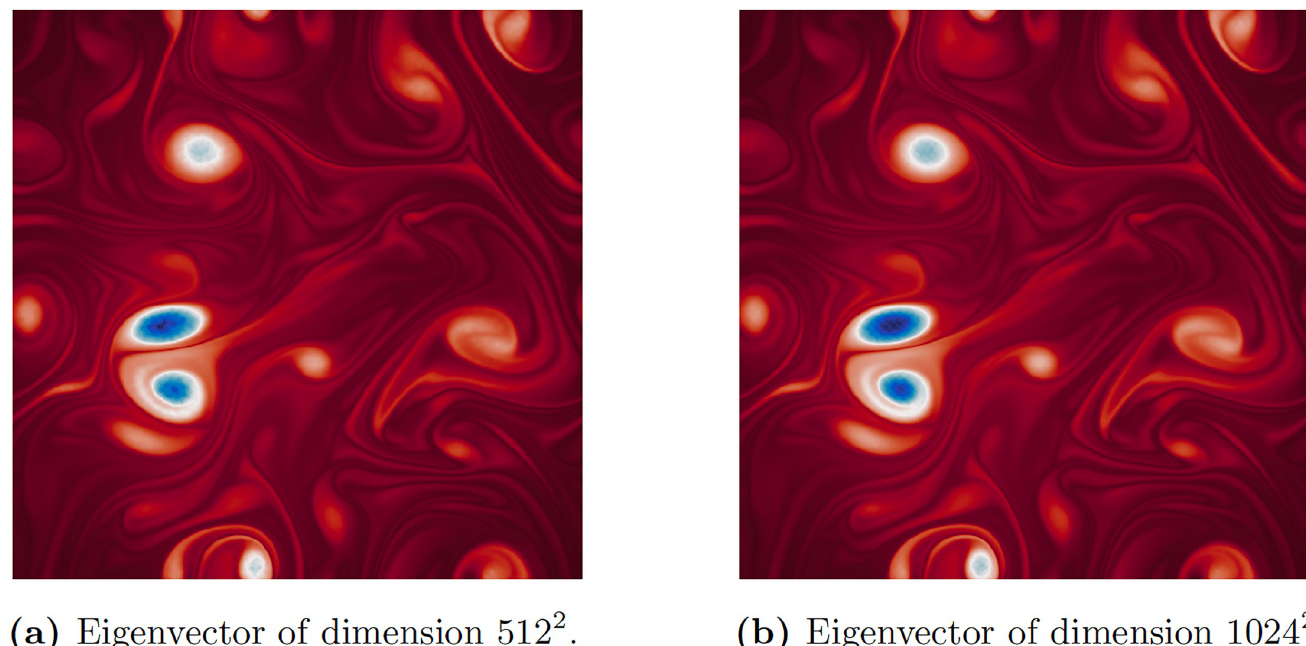
Fig 8. Approximated leading eigenvectors of the adjacency matrices for higher-resolution isotropic flow fields. Here, we are using the Nystro¨m method with Halton sampling. By visual inspection we can see that sampling only about 10% of the columns of the full adjacency matrix is sufficient for computing an approximated eigenvector that captures the dominant graph structure.